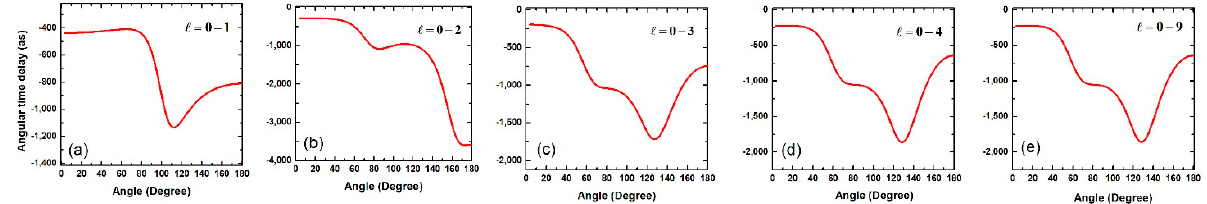
Figure 14. Angular time delay at the energy E 2 = 0.0340 a.u. plotted for different partial wave combinations ( a ) (cid:96) = 0–1, ( b ) (cid:96) = 0–2, ( c ) (cid:96) = 0–3, ( d ) (cid:96) = 0–4 and ( e ) (cid:96) = 0–9. In the case of far off-resonant energy E 3 = 0.1360 a.u., we expected that the contributions from more partial waves to the angular time delay would be significant. A step-wise addition of coupling ef- fects of partial waves with 0 5 = − is presented in Figure 15a–e. With the addition of each partial wave coupling, the changes in the profile of the time delay can be seen. Not only that, the contribu- tions from each non-resonant partial wave had equal representation. Coupling of the partial waves with 5 > did not alter the profile as expected (see Figure 15f,g).